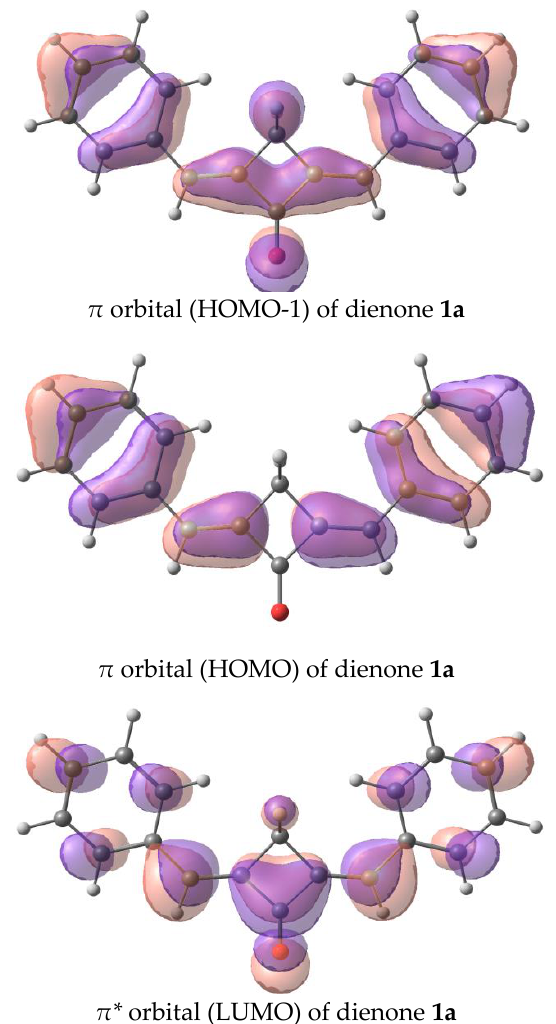
Figure 10. Orbitals involved in the first electron transition of dienone 1a , oxidation, and reduction.